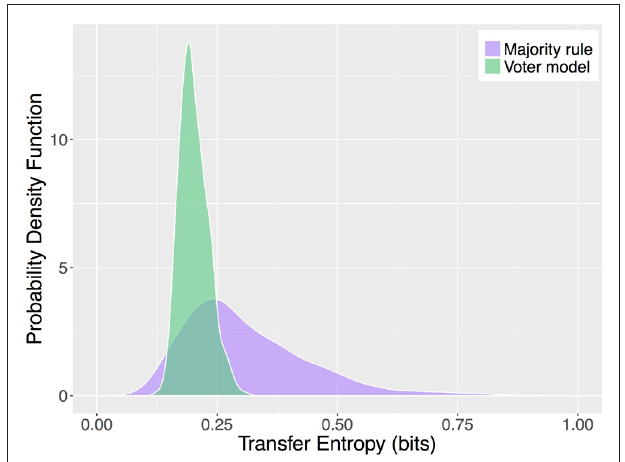
fIguRe 3 | Probability density functions of the average transfer entropy for agents in systems applying the majority rule (purple) and for agents in systems using the voter model